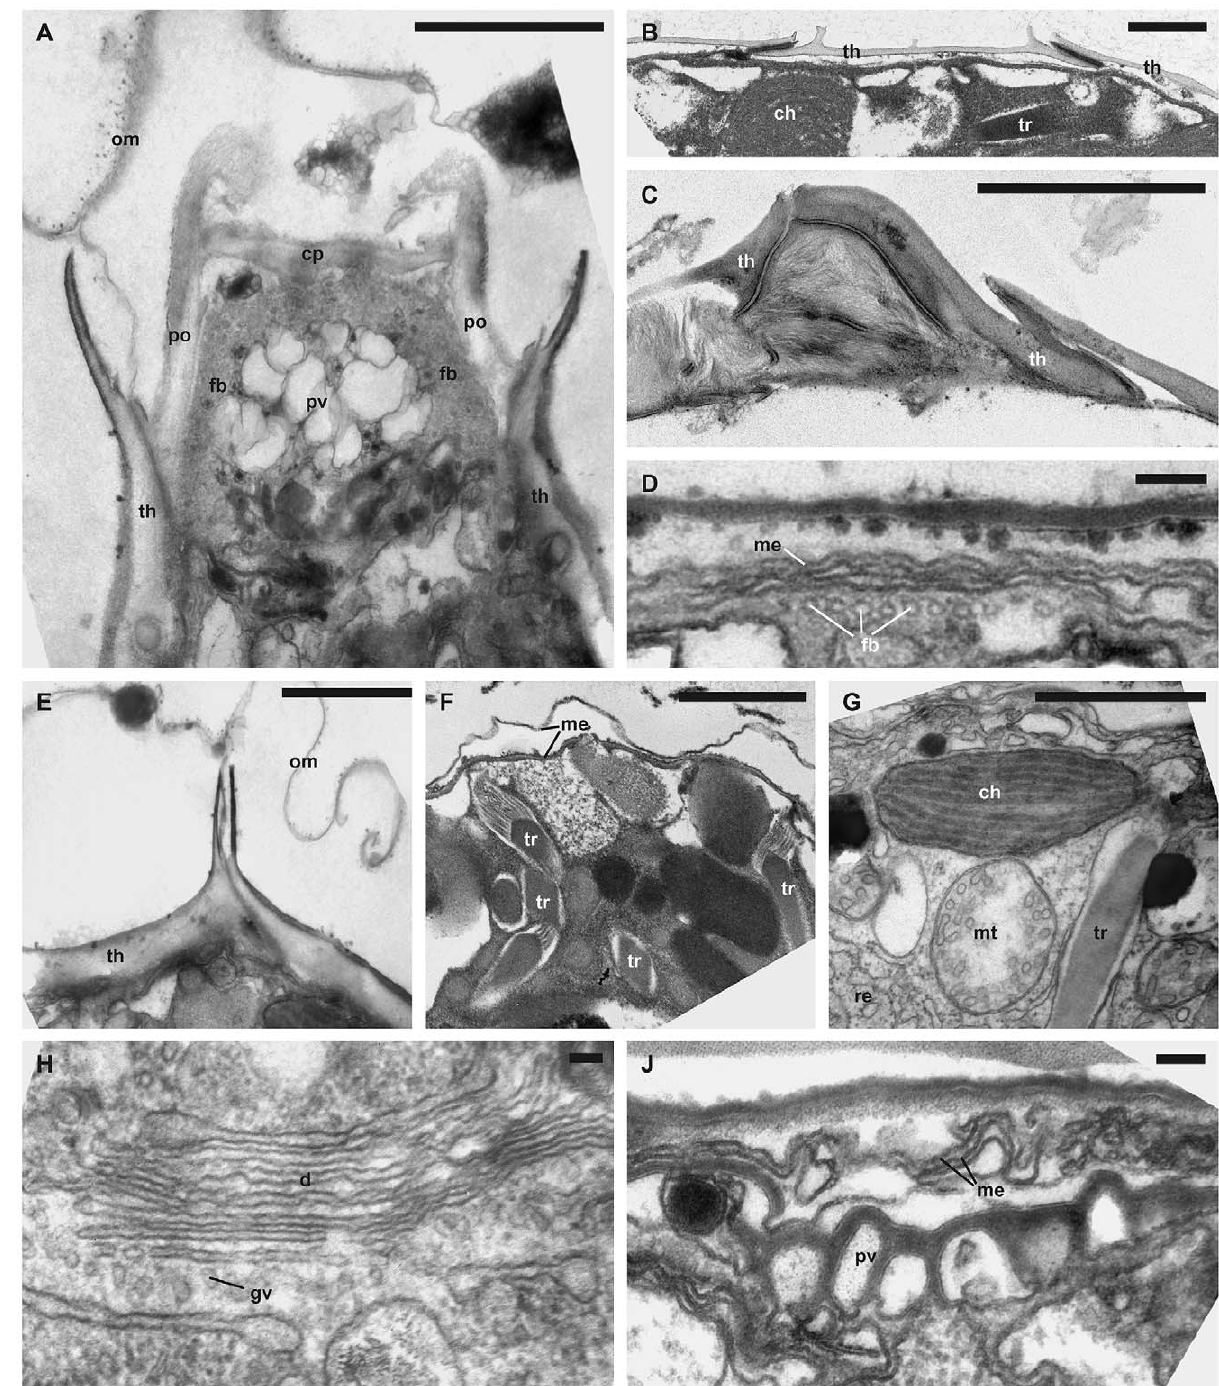
Figure 4. Ultrastructural traits in detail. (TEM). A. ‘Apical furrow’ system of Scripsiella trochoidea (GeoB 377, note the numerous vesicles under the cell surface). B. Overlapping thecal plates of Scripsiella trochoidea (GeoB 188, note the outer protrusions of overlapping theca plates). C. Overlapping theca plates in the sulcal region of ‘‘ Calciodinellum ’’ spec. (tub*2). D. Strand of peripheral microtubules in Scrippsiella bicarinata (GeoB 411, note the multiple membranes under the cell surface). E. Thecal plate boundary of Scripsiella trochoidea (GeoB 377, note the detached outer unit membrane). F. Trichocysts of Scrippsiella trochoidea var. aciculifera (GeoB 228). G. Subcellular organization of Scrippsiella bicarinata (GeoB 411, note the longisection of a trichocyst and the rough endoplasmatic reticulum indicated by an arrow). H. Golgi apparatus of Scrippsiella trochoidea (M34*25/ 5). J. Pusule of Scrippsiella bicarinata (GeoB 411, note the multiple membranes under the cell surface). Abbreviations: cb, crystal-like particle; ch, chloroplast; cp, cover plate; d, dictyosome, fb, microtubular fiber; gv, Golgi-derived vesicle; me, unit membrane; mt, mitochondrion; po, pore plate; pv, pusular vesicle; py, pyrenoid; re, rough endoplasmatic reticulum; st, starch grain; tr, trichocyst; th, thecal plate. Scale bars: A to C and E to G 1 m m, D, H, J 0.1 m m.